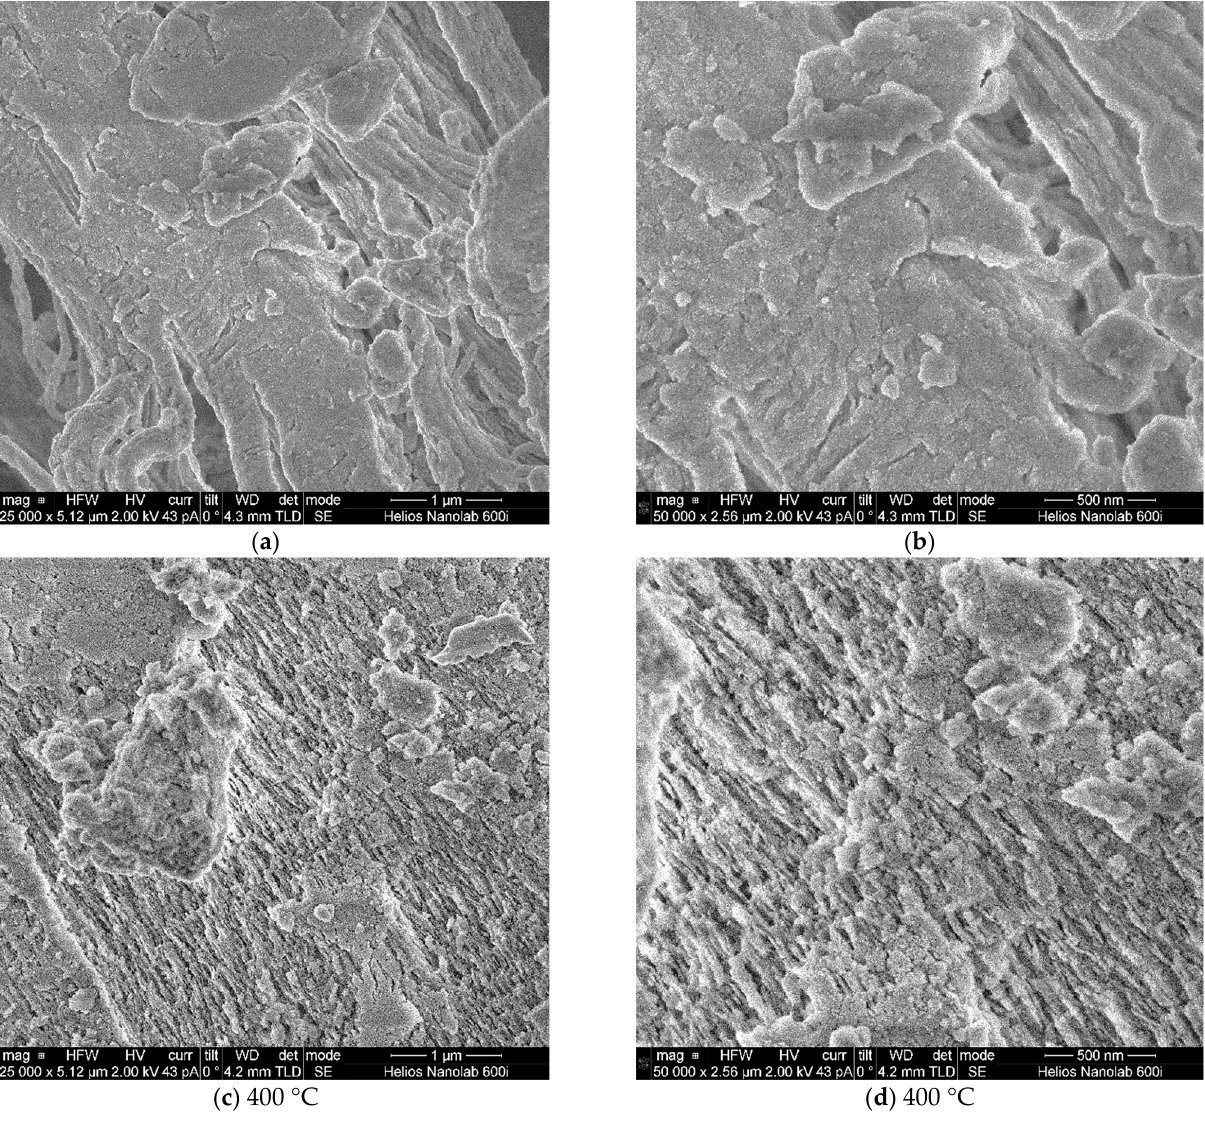
Figure 7. Micrographs of powders enriched with inorganic components prepared from the mixture of fish scales using high-speed grinding and vibration sieving before ( a , b ) and after heat treatment at 400 °C ( c , d ) using magnifications of ×25,000 ( a , c ) and ×50,000 ( b , d ). The phase composition of fish scale powders after heat treatment at 700–1000 °C (Figure 8) consisted of hydroxyapatite (Ca 10 (PO 4 ) 6 (OH) 2 (PDF card #9-432)) and magnesium whitlockite (Ca 2,82 Mg 0,19 (PO 4 ) 2 (PDF card #70-682) or Ca 18 Mg 2 H 2 (PO 4 ) 14 (PDF card #70-2064)) according to the ICDD database [29]. According to the Match! software database, the phase composition of fish scale powder after heat treatment at 1000 °C can be described as containing: hydroxyapatite (Ca 10 (PO 4 ) 6 (OH) 2 (card 96-900-2215)) or hydroxyapatite-dental (Ca 4.7 H 0.46 Mg 0.05 Na 0.1 O 12.51 P 1.61 (card 96-900-2220)) and magnesium whitlockite (Ca 10.115 Mg 0.385 (PO 4 ) 7 (card 96-901-2137) or Ca 9.5 Mg(PO 4 ) 7 (card 96-901-2138)). According to Match!, the phase composition was determined to contain 71.8–73.4 wt.% hydroxyapatite and 26.6–28.2 wt.% magnesium whitlockite.